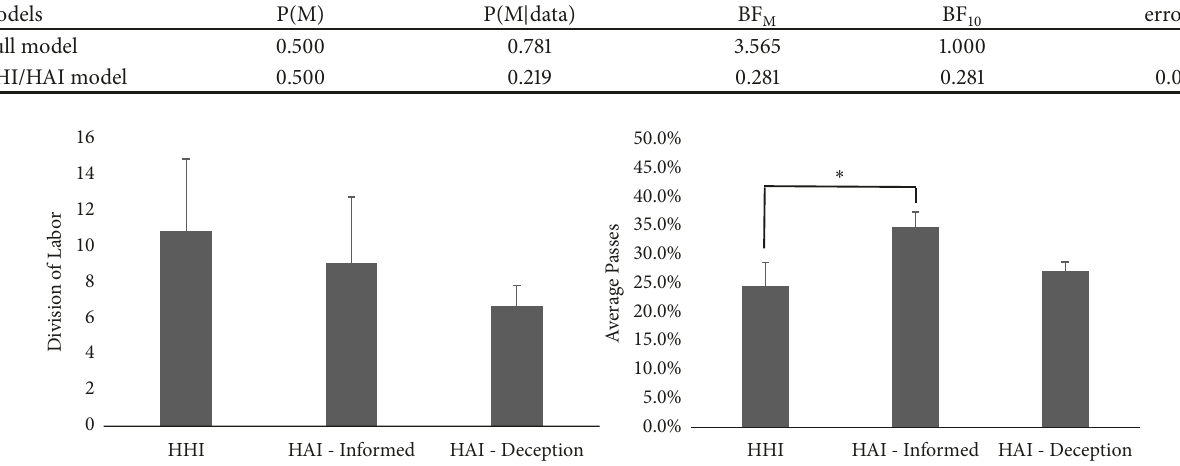
Figure 7: Average percentage of passes for each experimental